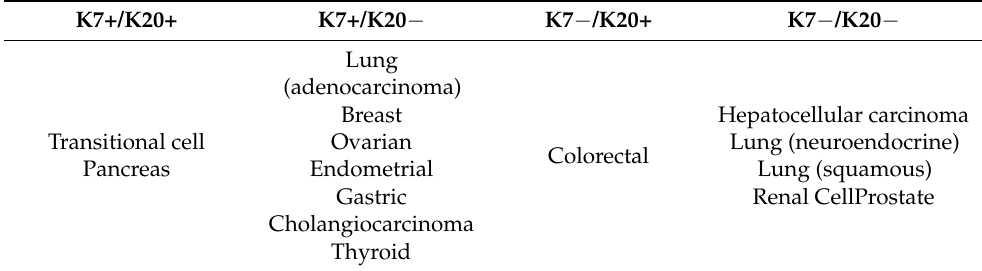
Table 1. Initial diagnostic algorithm for cancer of unknown primary